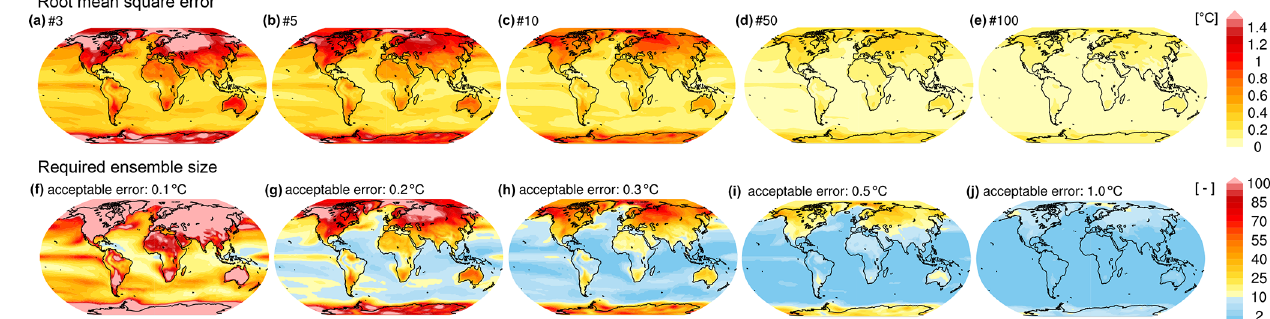
Figure 3. (a–e) The mean RMSE for the forced response in historical monthly mean near-surface air temperature of MPI-GE for (a) 3, (b) 5, (c) 10, (d) 50, and (e) 100 ensemble members relative to the 200-member mean, globally. The RMSE shown here is the mean from 100 random samples without replacement. (f–j) Required ensemble size to capture the 200-member mean forced response in historical monthly mean near-surface air temperature dependent on the acceptable error of (f) 0.1, (g) 0.2, (h) 0.3, (i) 0.5, and (j) 1.0 ◦ C.